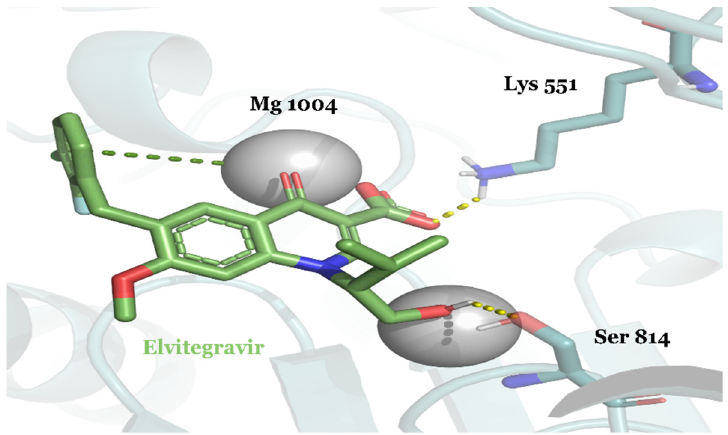
Figure 11. Elvitegravir-selected docking pose. RdRp’s residues are colored according to the atom type of the interacting amino acid residues (protein’s carbon, light teal; oxygen, red; nitrogen, blue). Dash lines represent the protein–ligand interactions: hydrogen bond interactions are colored in yellow; π - π interactions are colored in blue; π -cation interactions are colored in green.